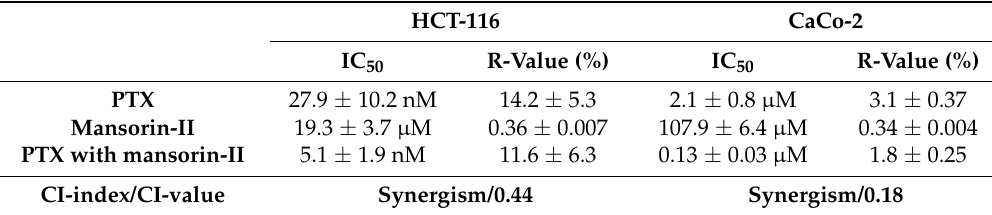
Table 2. Effect of mansorin-II on the cytotoxicity parameters of PTX in colorectal cancer cell lines.